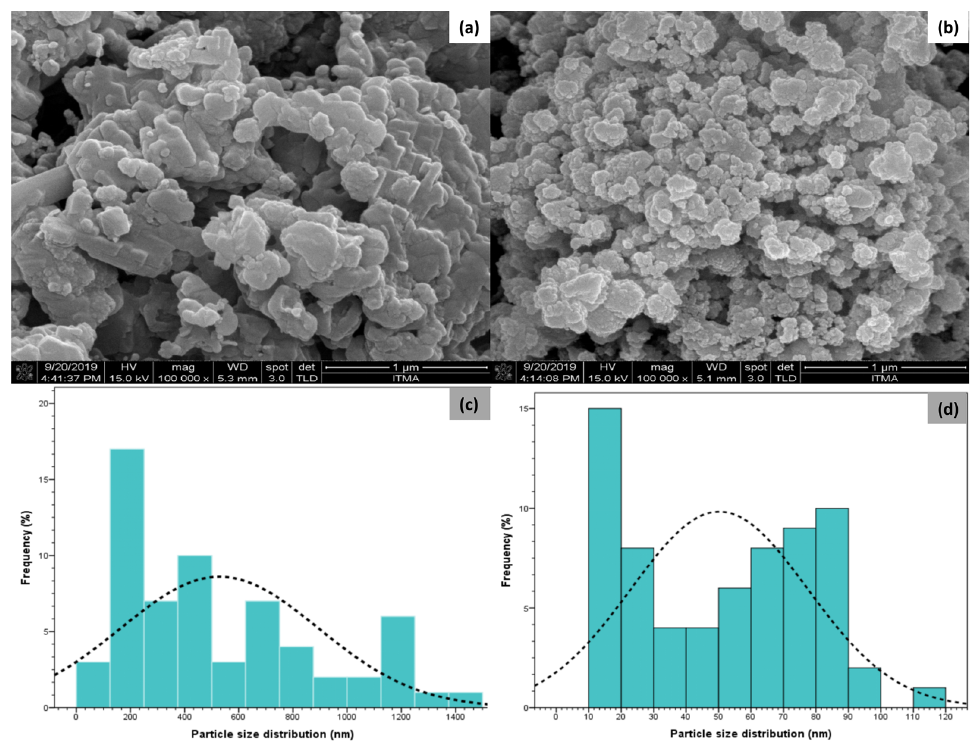
Figure 7. FESEM images of ( a ) CP ( b ) nCPs; Particle size distribution of ( c ) CP ( d )